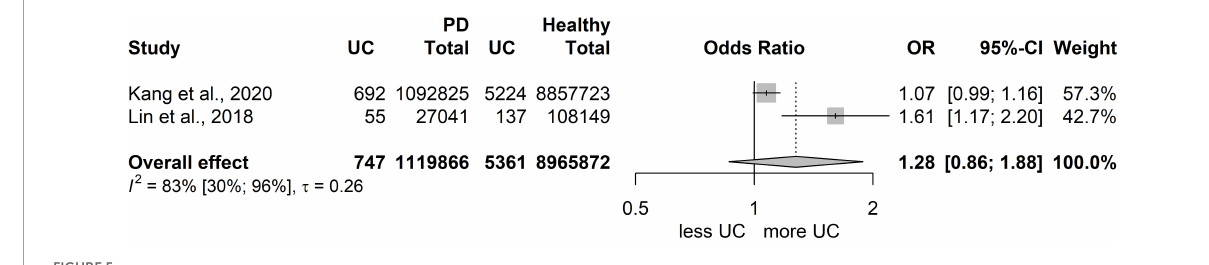
FIGURE5 Risk for developing ulcerative colitis (UC) in patients with periodontitis.